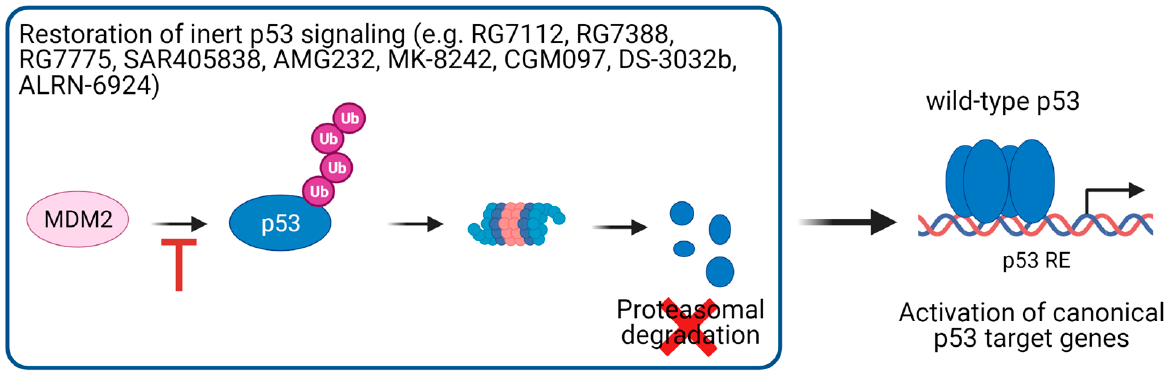
Figure 7. Therapeutic strategies of targeting wild-type p53. In tumors with inert p53 signaling, p53 signaling could be reactivated by using MDM2 inhibitors, thereby rescuing p53 from MDM2-mediated proteasomal degradation. RE, response element. Table 1. Overview of compounds targeting wild-type or mutant p53 in clinical trials in colorectal cancer or solid tumors